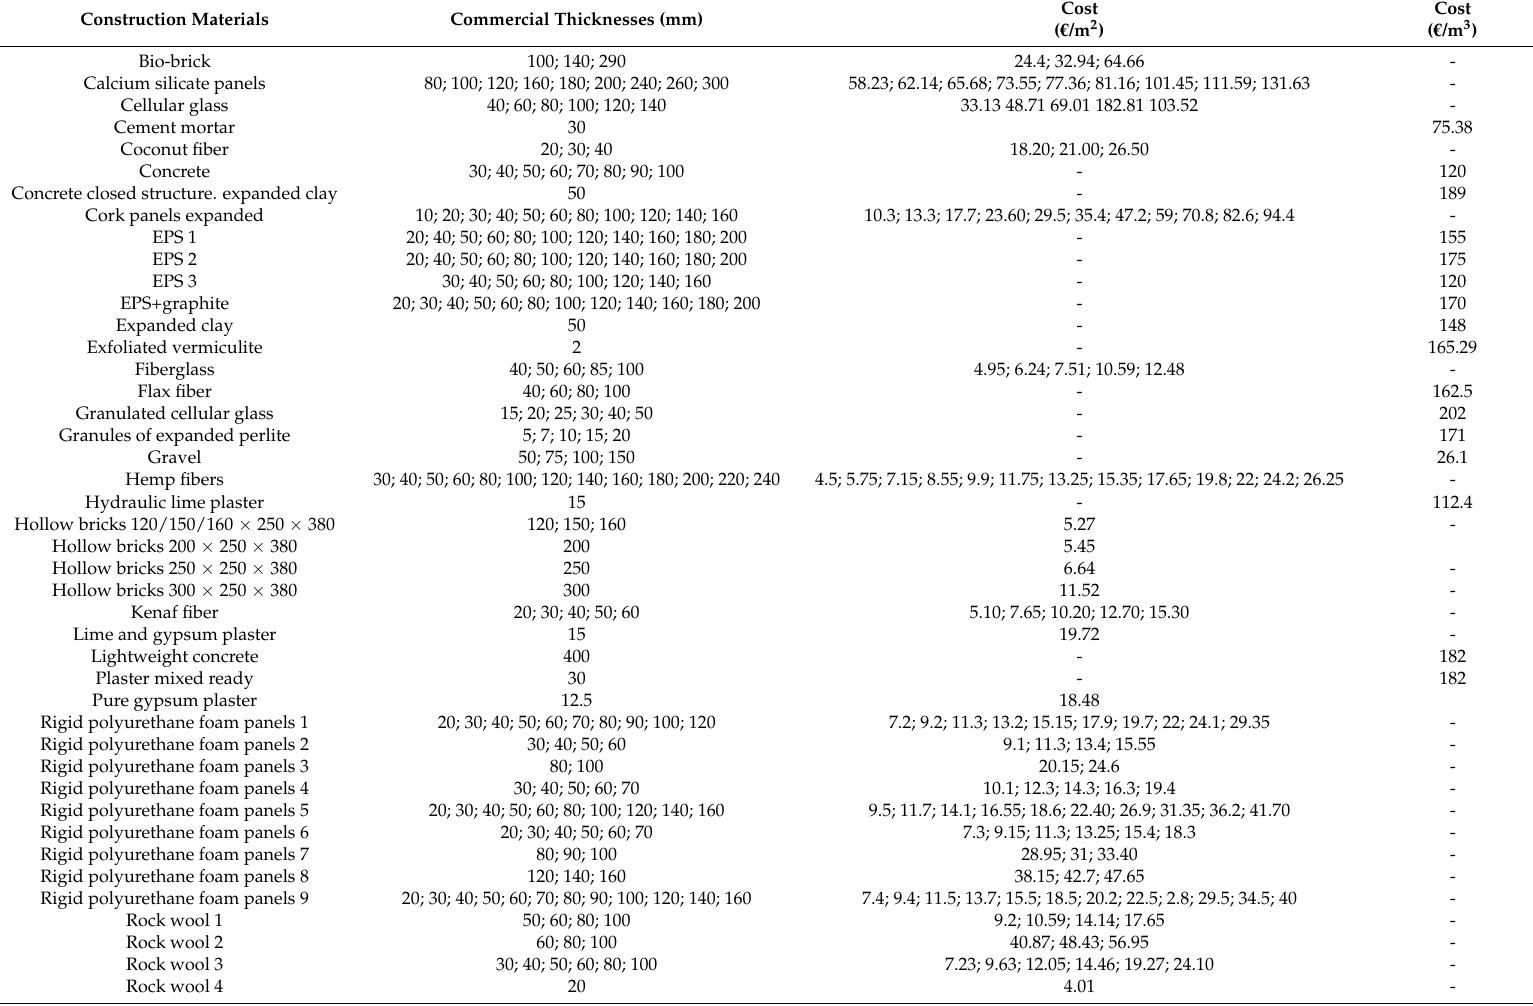
Table 5. Costs of the building